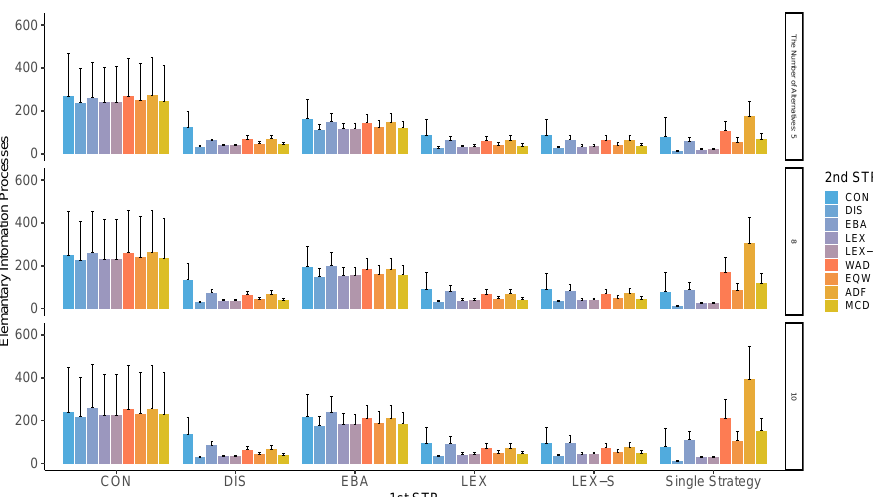
Figure 2. Average elementary information processes in two-stage decision-making when the number of alternatives left in the second stage is two for the different number of alternatives. Note: ADF: additive difference; CON: conjunctive; DIS: disjunctive; EBA: elimination by aspects; EQW: equal- weighted strategy; LEX: lexicographic; LEX-S: lexicographic semi-order; MCD: majority of confirming dimensions; STR: strategy; WAD: weighted additive.